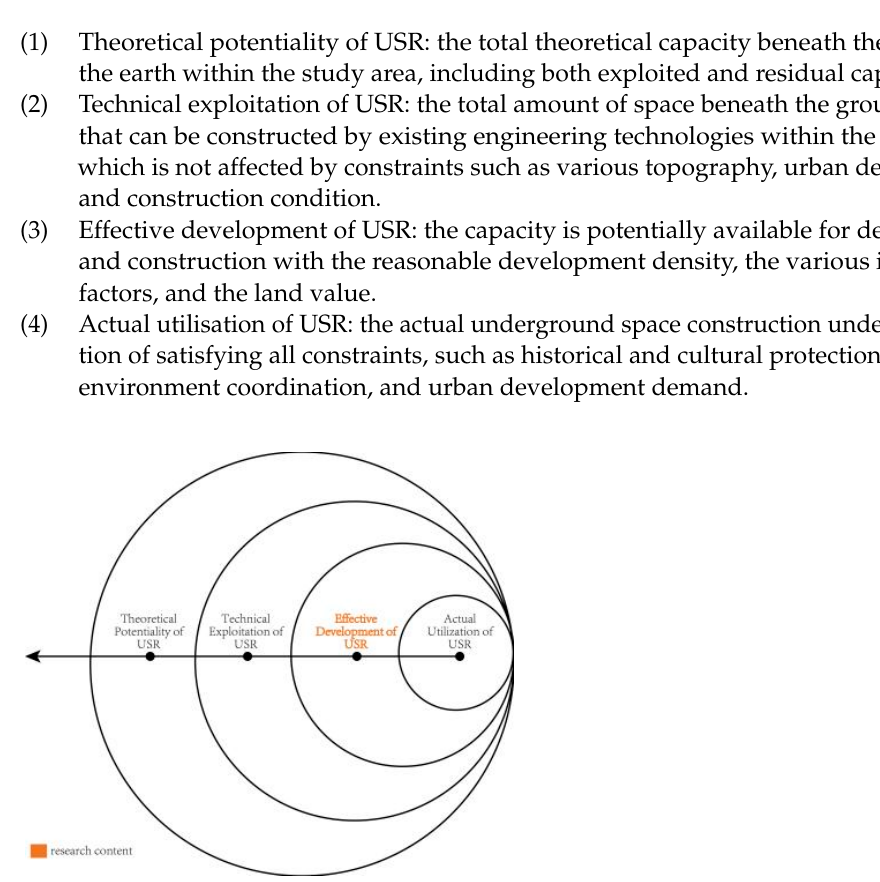
Figure 9. Process of capacity evaluation of USR.